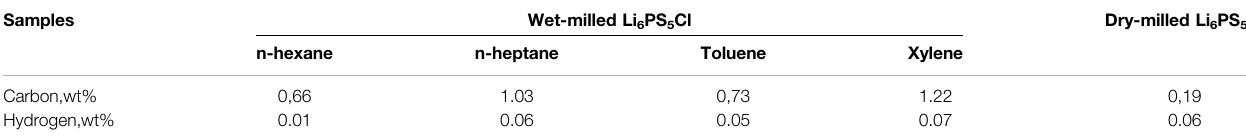
TABLE 3 | Ionic conductivities Li 6 PS 5 Cl electrolyte pellet samples.